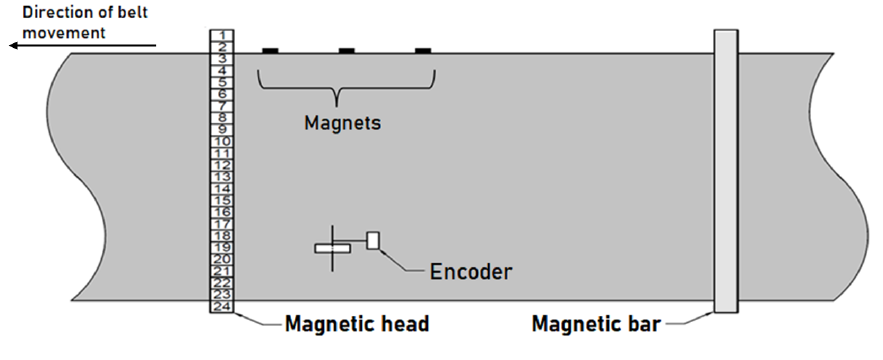
Figure 1. Scheme of the HRDS measuring system.